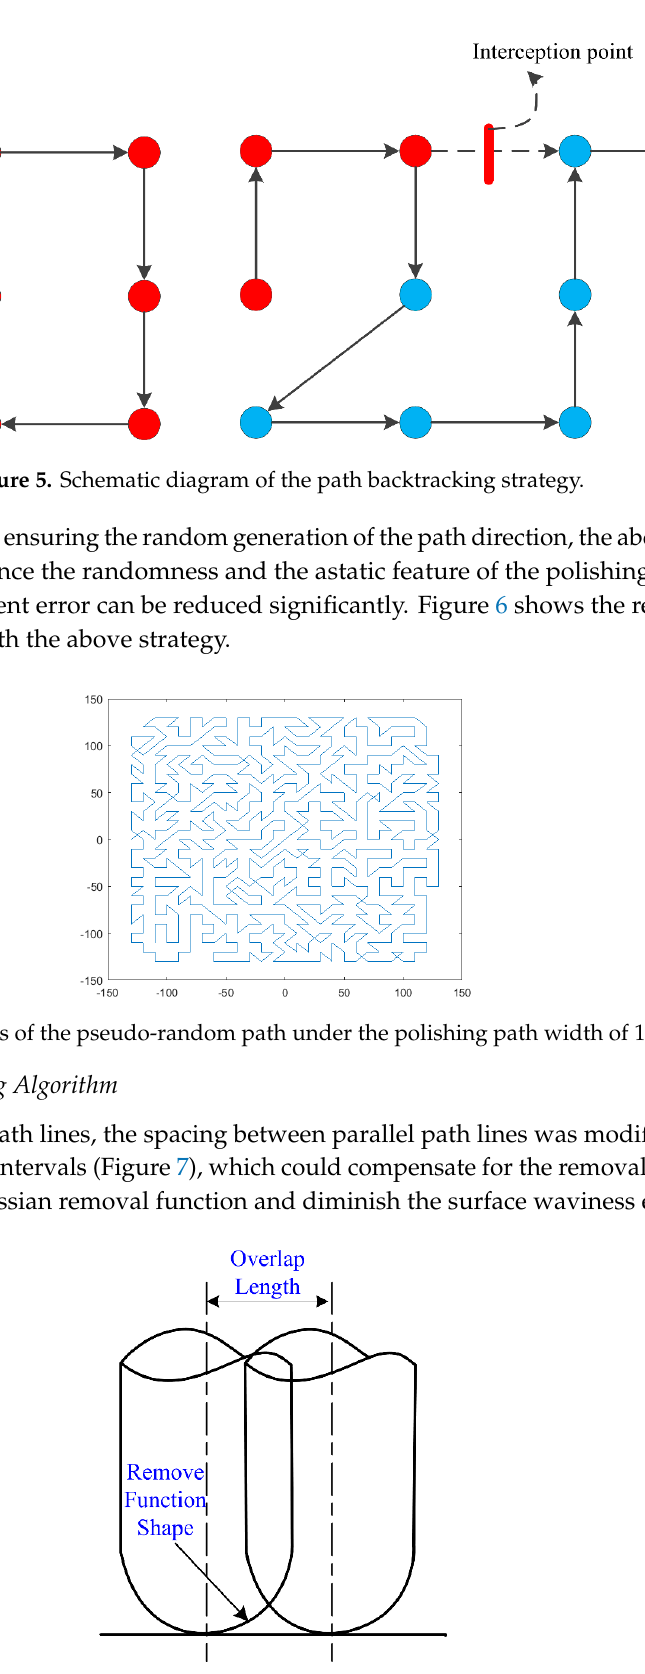
Figure 7. Schematic diagram of the overlapping path.